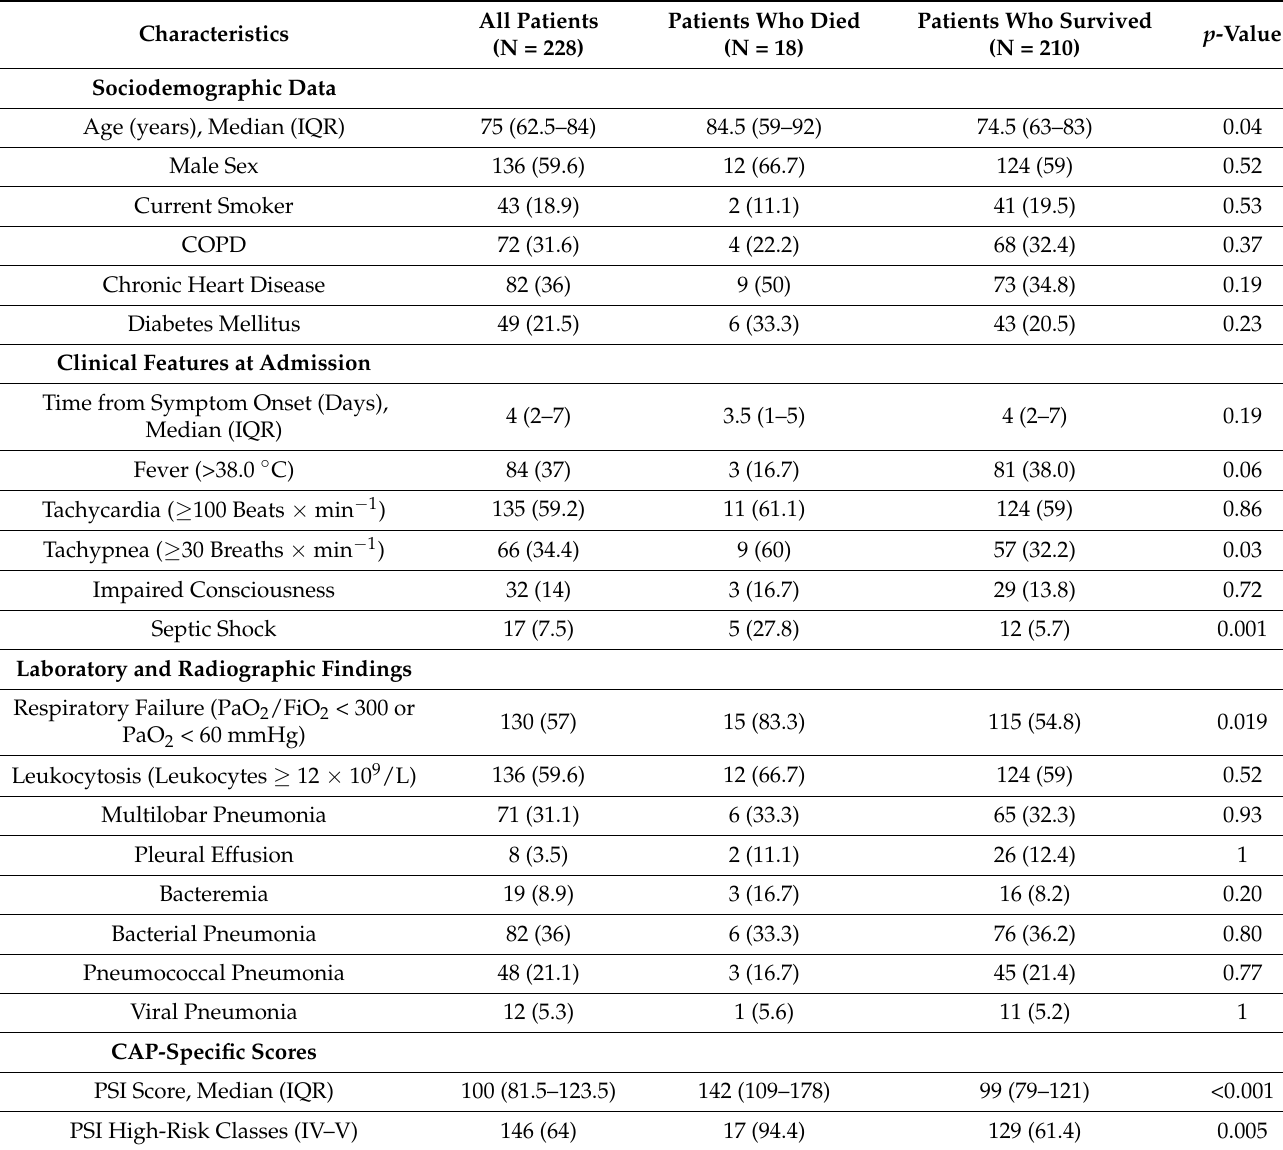
Table 1. Characteristics of hospitalized patients with community-acquired